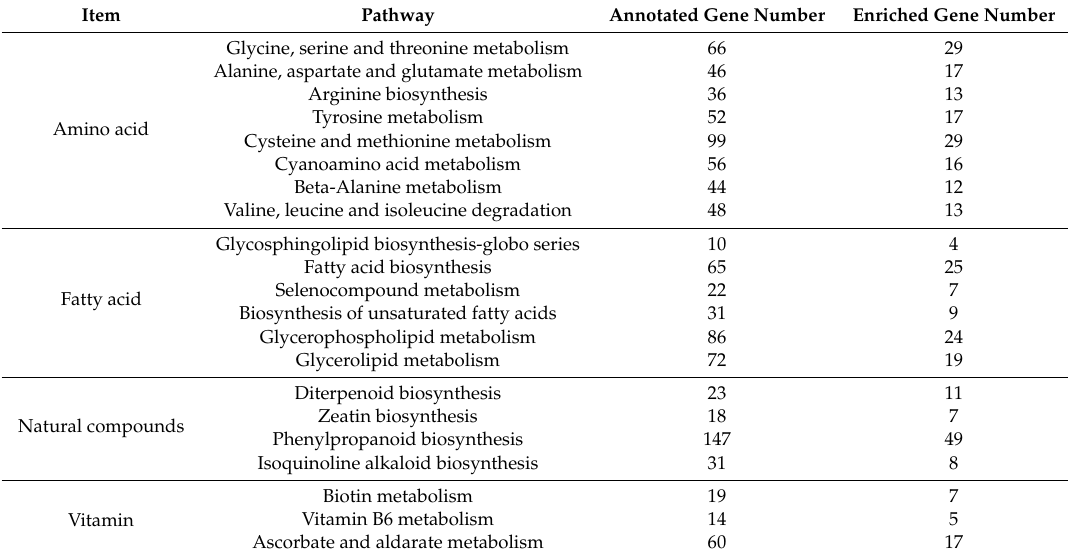
Table 3. The nutrition-related KEGG pathways enriched by upregulated genes.